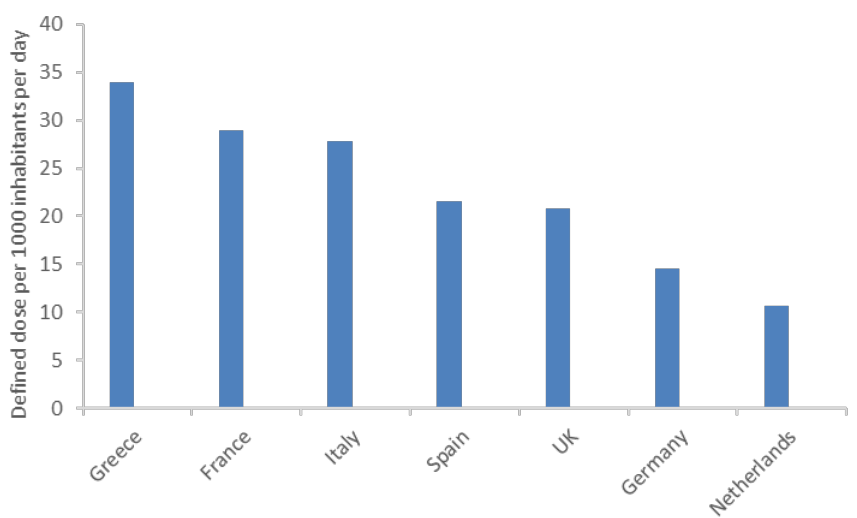
Figure 1. Antibiotic consumption (defined as dose per 1000 inhabitants per day) across EU countries in 2014. Adapted from [4].